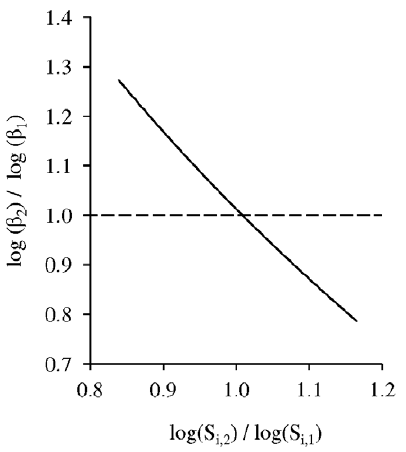
Figure 5. Relationship between optimal b 2 / b 1 ratio and S i,2 /S i,1 ratio in the absence of pre-existing immunity. The optimal infectivity rate in the bronchiolar compartment ( b 2 ) is smaller than the optimal infectivity rate in the tracheo-bronchial compartment ( b 1 ) provided that the initial number of susceptible cells in the bronchiolar compartment (S i,2 ) is larger than the initial number of susceptible cells in the tracheo-bronchial compartment (S i,1 ).